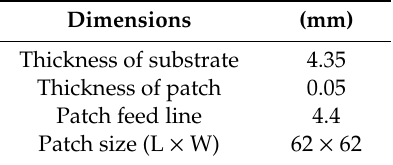
Table 2. Geometrical dimensions for all antennas.